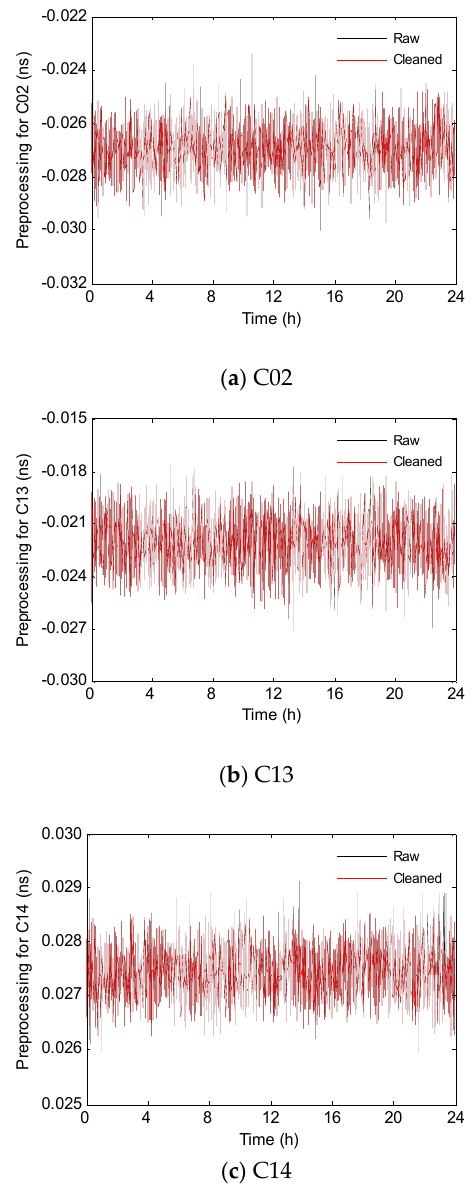
Figure 3. Preprocessing for satellite clock offsets. The raw data series are presented in black, while a cleaned time series getting rid of abnormal data are in red.